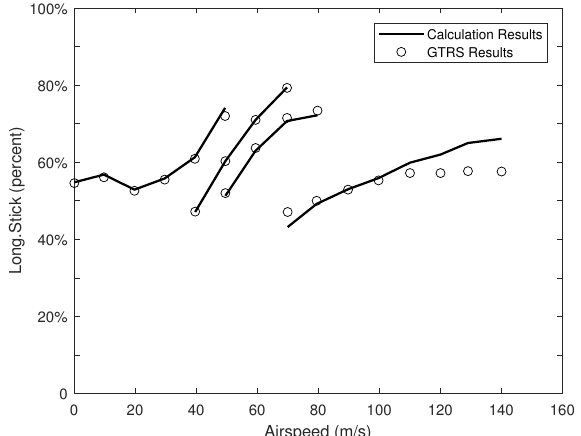
Figure 3. Collective pitch trim validation.